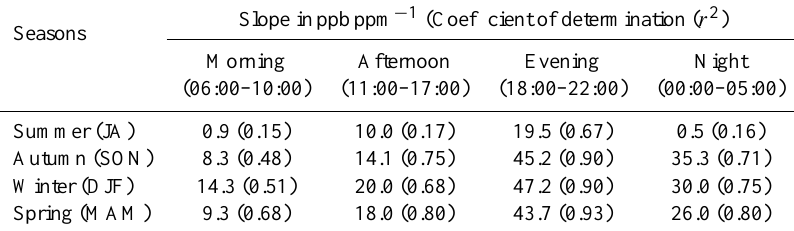
Table 1. Correlation slopes ( (cid:49) CO ( exc ) /(cid:49) CO 2(exc) inppbppm − 1 ) measured during different time intervals of distinct seasons. Coefficient of determination ( r 2 ) is given inside the